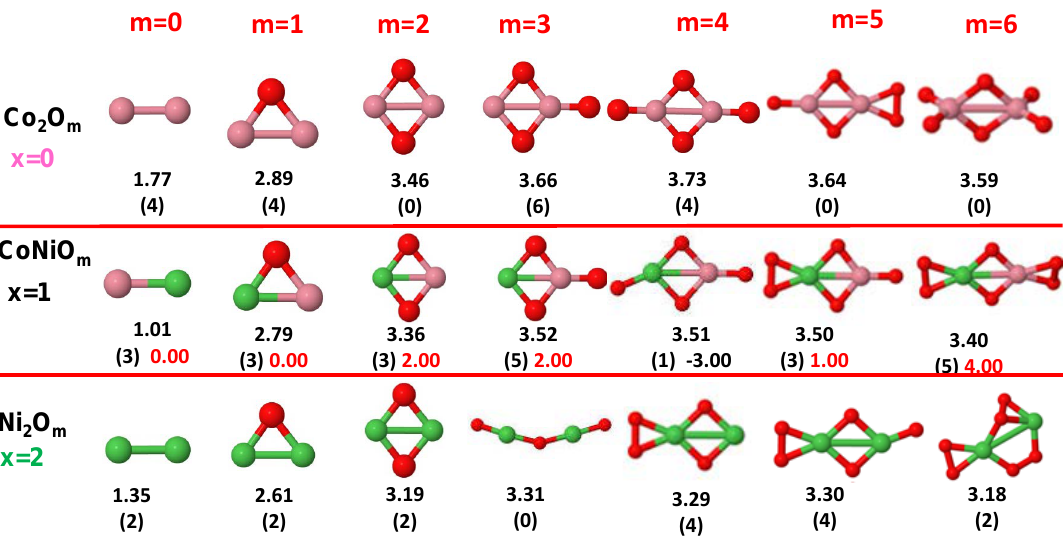
Figure 2. Putative global minimum structures of Co 2 − x Ni x O m , x = 0–2, m = 1–6. Numbers below structures are the binding energy per atom (in eV), numbers in parentheses are the magnetic moment (in µ B ) and the third number (when present) is the excess magnetic moment (in µ B ) defined in Equation (2). Co atoms in pink color, Ni atoms in green and oxygen atoms in